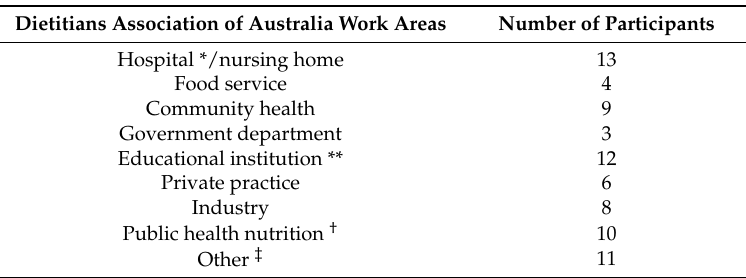
Table 2. Number of participants in Dietetics Association of Australia work